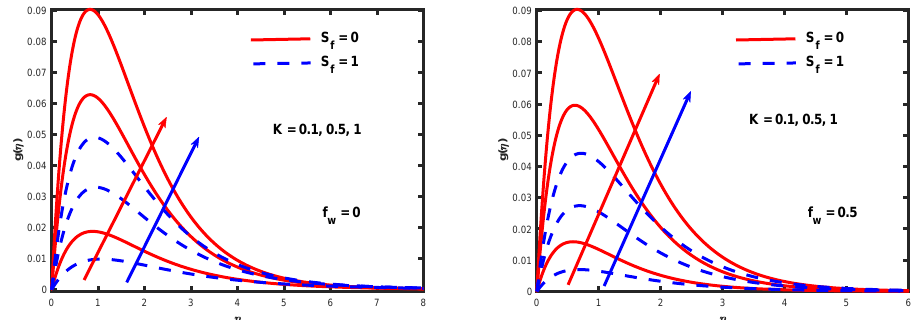
Figure 6. Influence of buoyancy and suction/injection parameter on g .